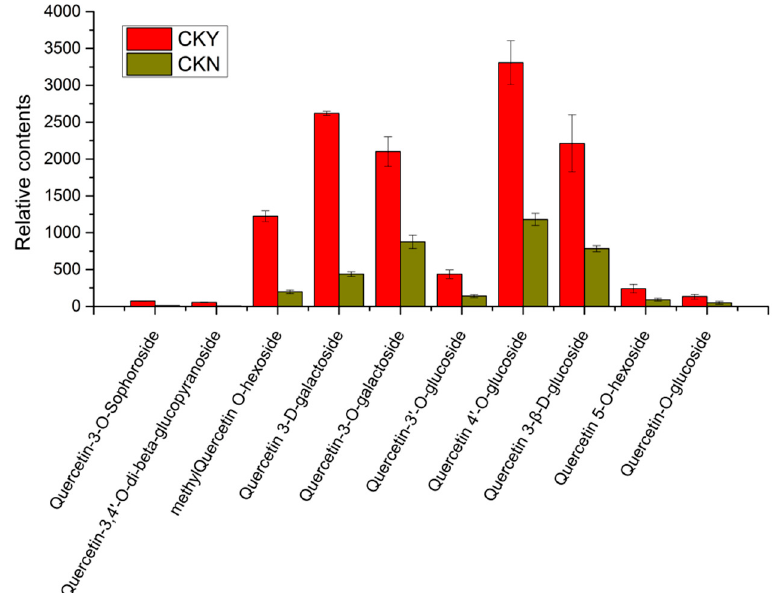
Figure 6. Relative content of key di ff erential metabolites in russet CKY versus non-russet CKN.